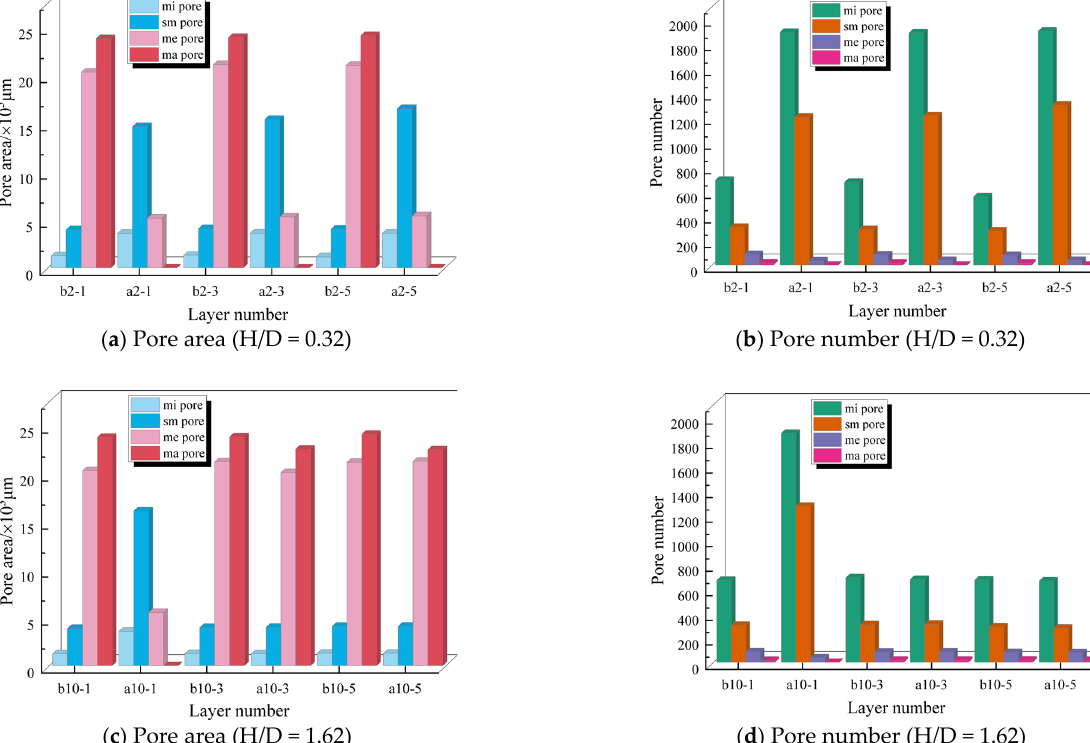
Figure 9. The distribution of pore area and pore number at the compaction degree of